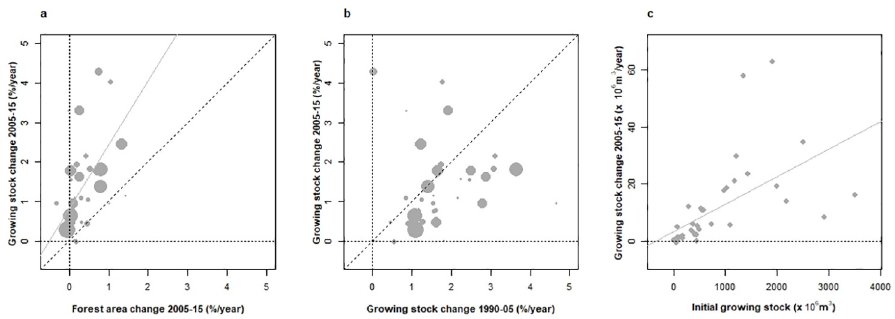
Fig 2. Changes in the growing stock of European countries under study and their comparison with forest area changes and across time. (a) While both the rates of forest area and growing stock changes over 2005–2015 predominantly positive, growing stock change remains greater than that of forest area (slope of regression weighted by forest area in 2015: +1,62 (p < 10 − 5 ). (b) Rates of change in the growing stock over the two successive periods 1990– 2005 and 2005–2015 demonstrate significant inertia (correlation weighted by forest area in 2005: +0.46 (p < 0.01, excluding Romania with growing stock shift generated by NFI implementation). (c) Absolute growing stock change against absolute growing stock shows a proportional trend suggesting capital-driven open dynamic (slope of regression: p < 10 − 7 ): +0.57 (p < 10 − 3